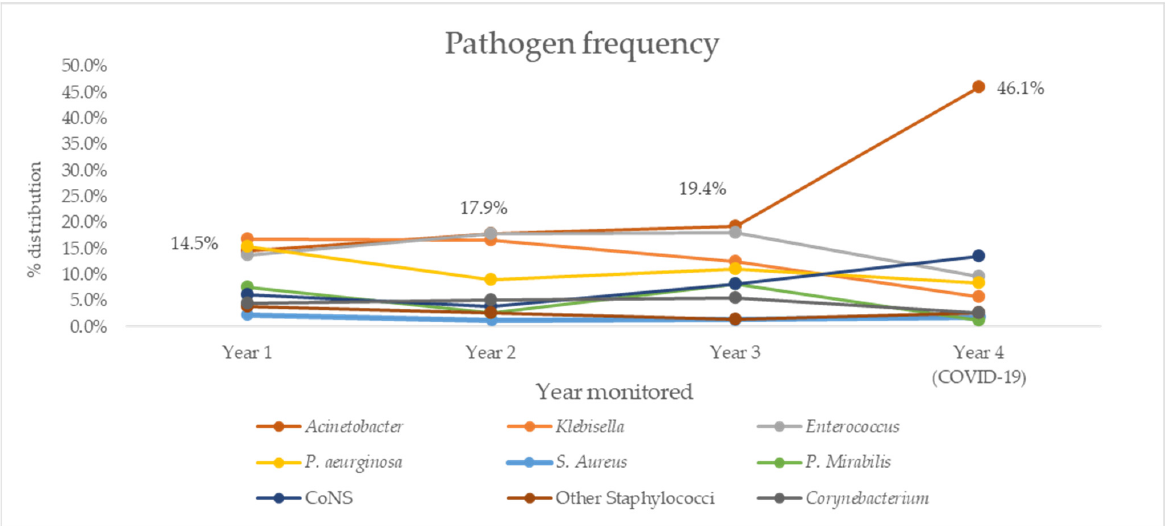
Figure 2 Figure 2. Distribution of most commonly isolated causative agents of HAIs in our ICU over four years of follow-up. CoNS,